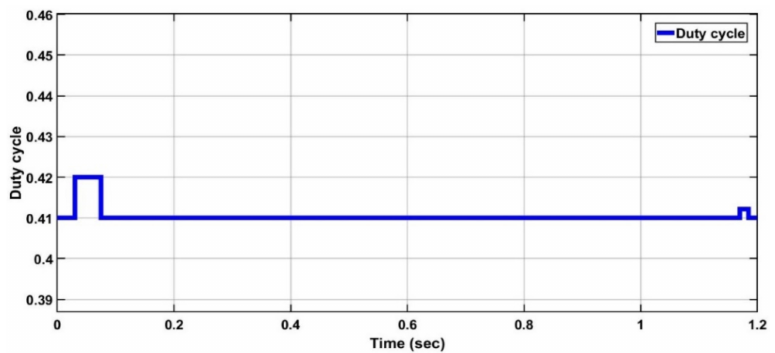
Figure 40. V pv of Firefly Algorithm (Case-4).